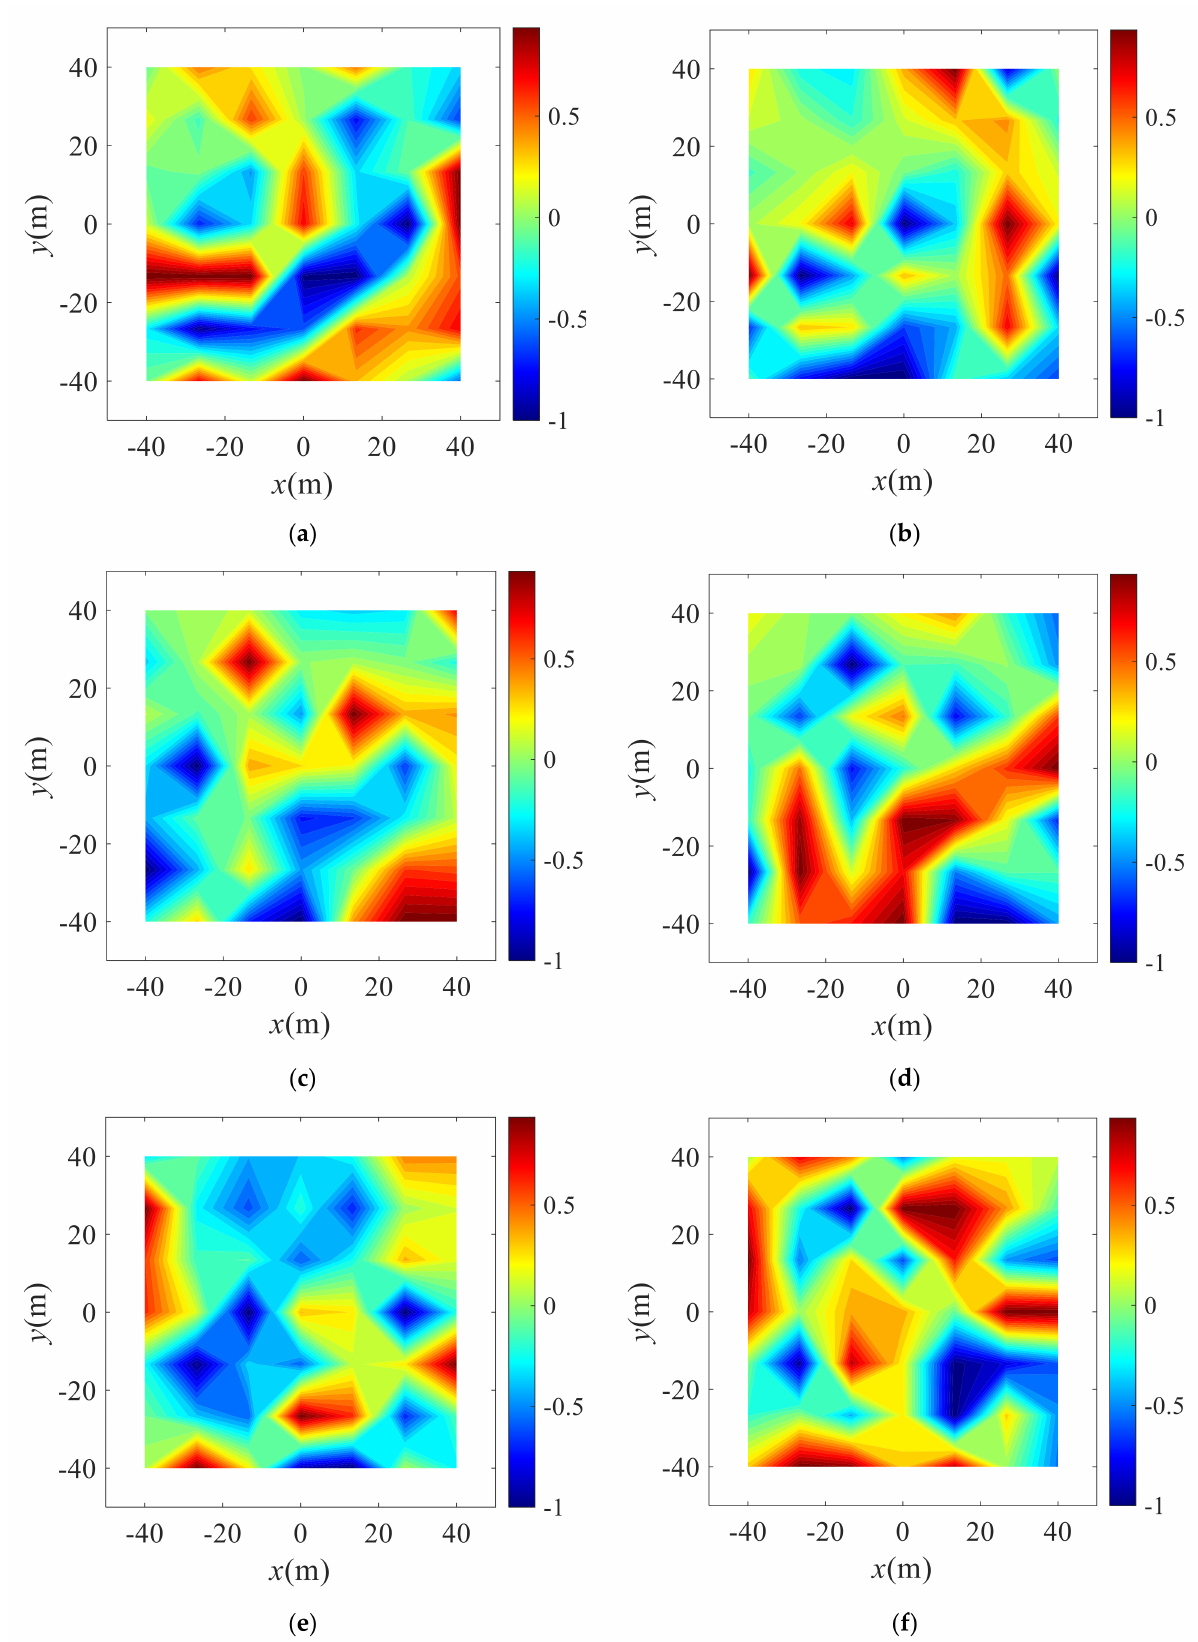
Figure 5. Eigenvectors by SVD: #1 ( a ), #2 ( b ), #3 ( c ), #4 ( d ), #5 ( e ) and #6 ( f